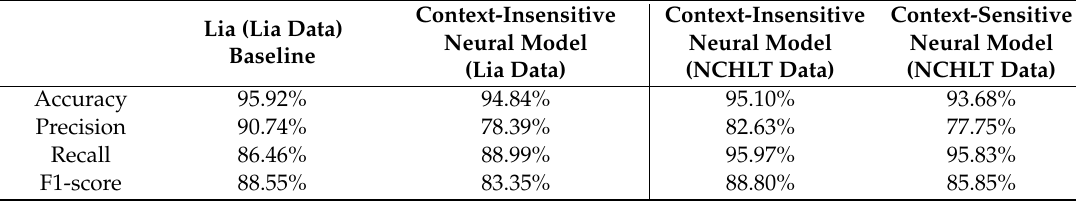
Table 9. Lemmatisation results for